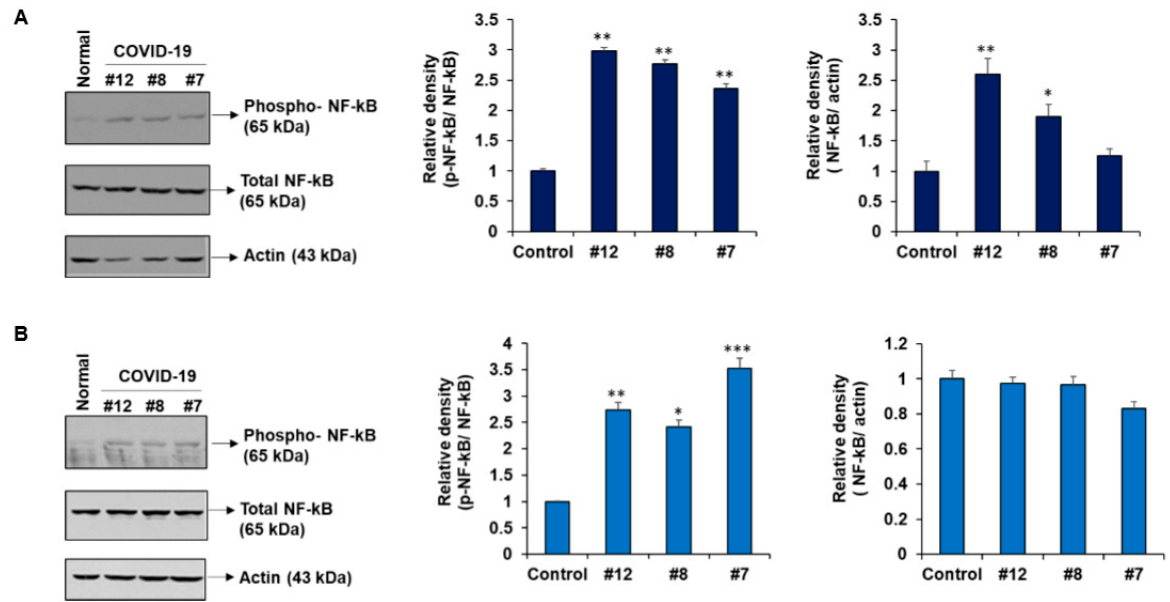
Figure 5. Exosomes from plasma of COVID-19 patients activates NF- κ B signaling in hepatocytes. IHH ( A ) or Huh7 cells ( B ) were exposed to normal and COVID-19 exosomes for 48 h and cell lysates were subjected to Western blot analysis for phospho-NF- κ B p65 (Ser536), NF- κ B p65 using specific antibodies. The membrane was reprobed for actin as an internal control. The same actin blot from Huh7 cells is used in Figure 4c. The right panel shows quantitative representation of Western blot band intensities. Small bar indicates standard error (* p < 0.05; ** p < 0.01; *** p <0.001).